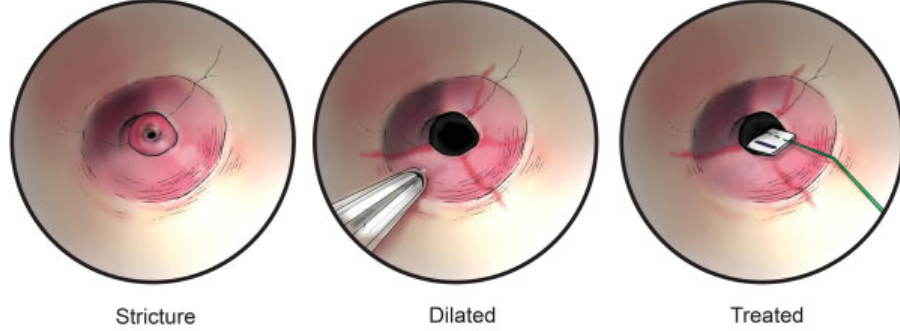
Fig. 2 Illustration of an endoscopic view of an esophageal stricture dilated by balloon and treated with a cottonoid soaked in mitomycin C. (Illustration by Scott Holmes, reprinted with permission from Baylor College of Medicine, Houston, Texas, United